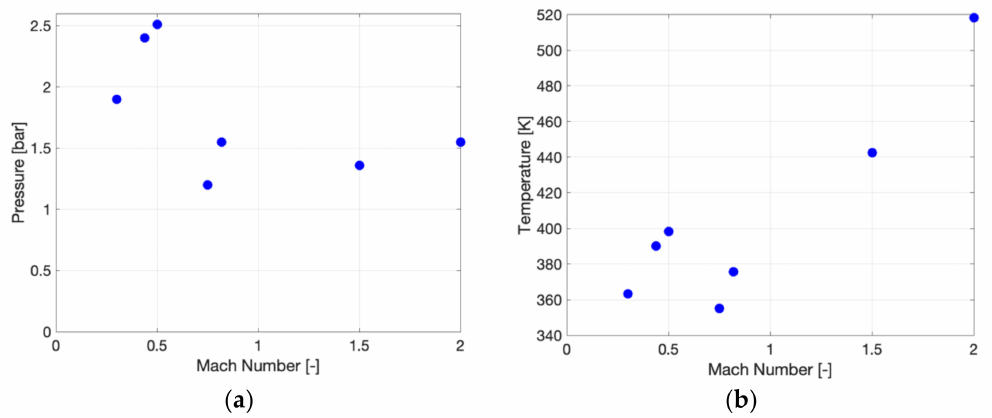
Figure 4. ( a ) Pressure versus Mach of the bleed-air (ATR engine); ( b ) temperature versus Mach of the bleed-air (ATR engine).